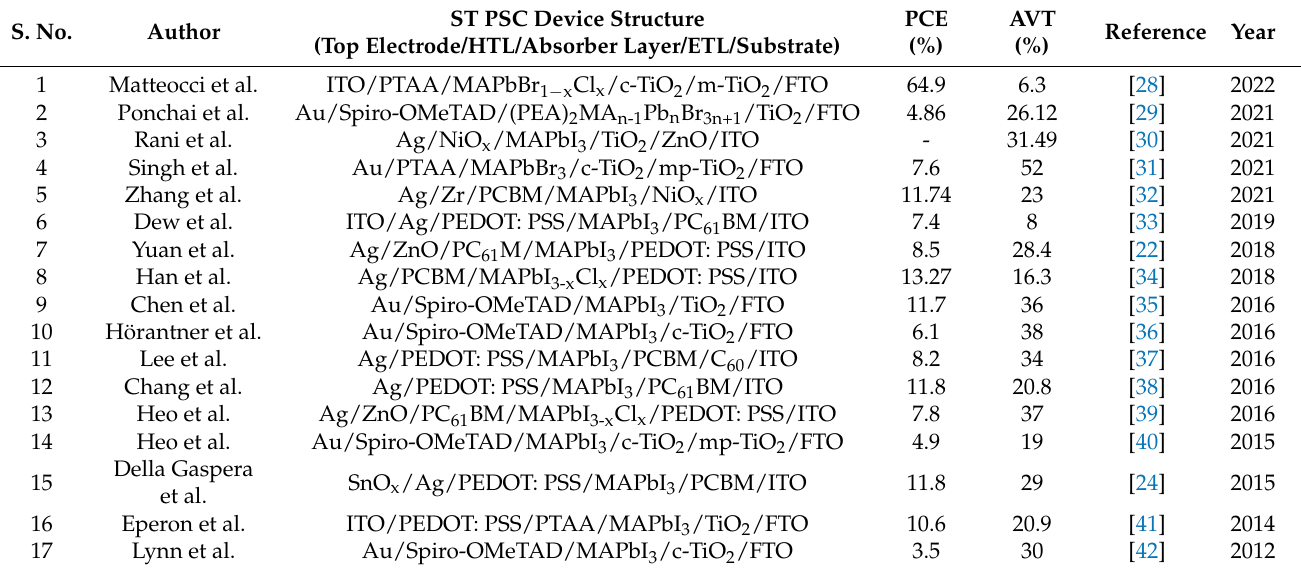
Table 1. ST PSC structures developed in the past